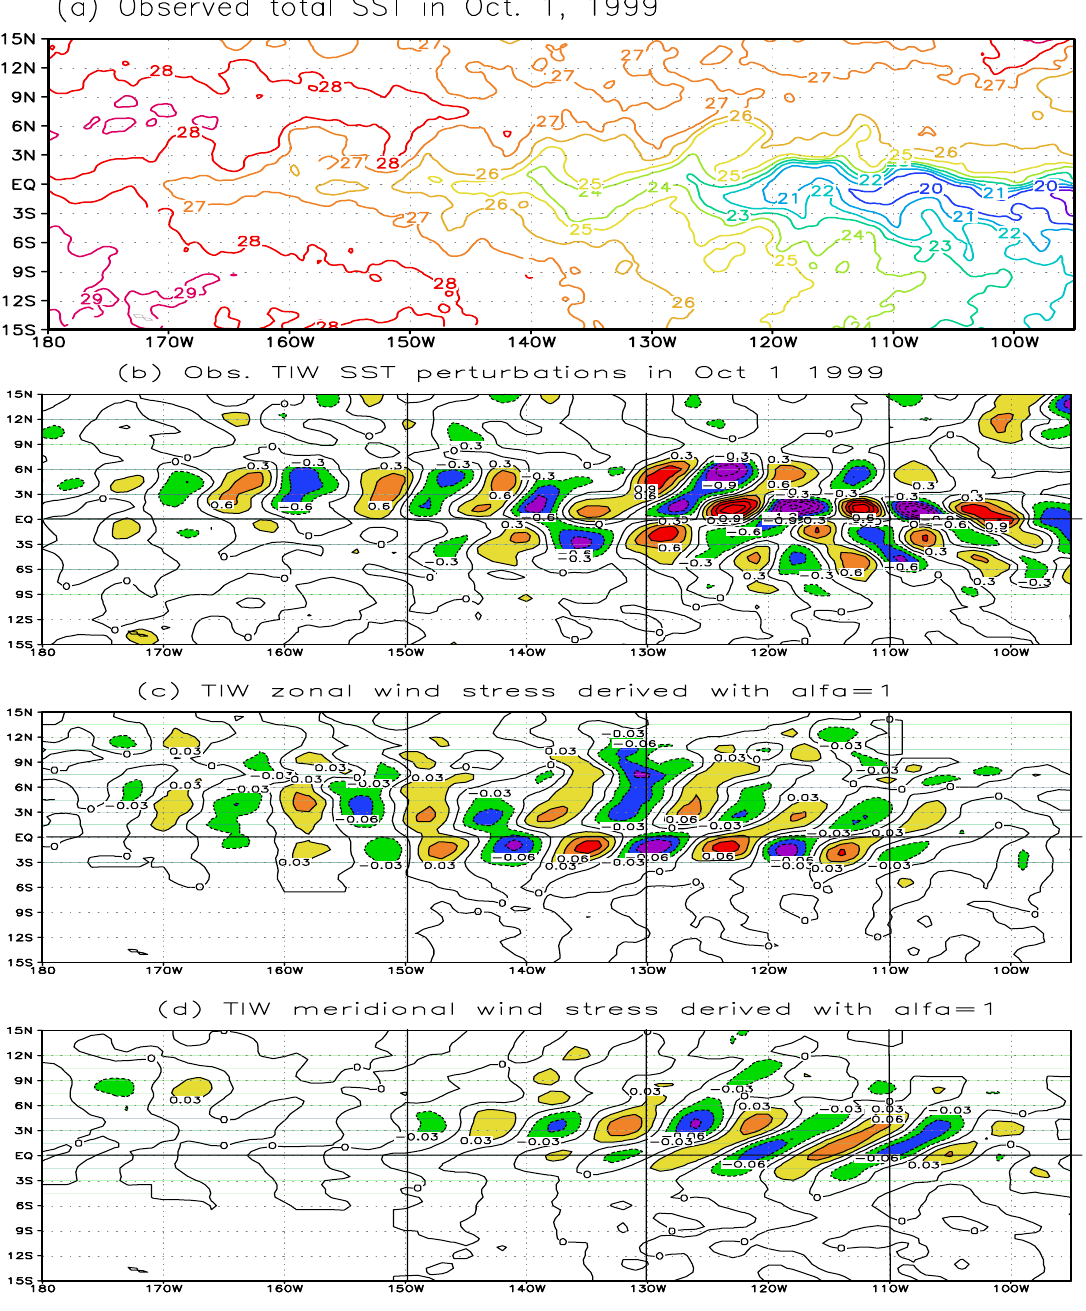
Figure 2. Horizontal distributions of ( a ) total sea surface temperatures (SSTs) and ( b ) the zonal-high-pass filtered SST fields (SST ) on 1 October 1999 from the satellite data, and TIW of the TIW-induced ( c ) zonal and ( d ) meridional wind stress components on 1 October 1999, simulated from the SST fields in (b) using the empirical τ model with α = 1 taken TIW TIW TIW and the first 10 singular vector decomposition (SVD) modes retained. The contour interval is 1 °C in (a), and 0.3 °C in (b), and 0.03 dyn·cm −2 in